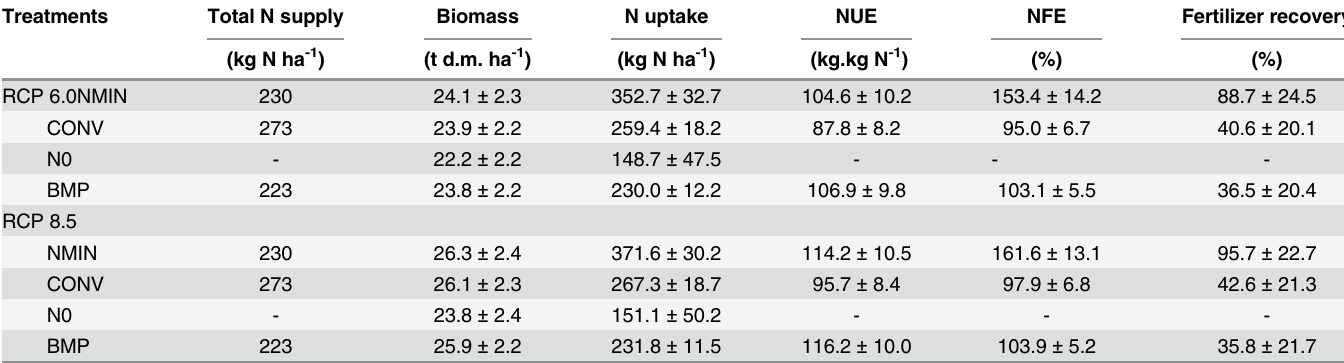
Table 10. Simulated yearly averages of total N supply, biomass (expressed as dry matter), N uptake, N use efficiency (NUE), N fertilizer efficiency (NFE) and fertilizer recovery related to the maize crop for the NMIN, CONV, N0 and BMP treatments in the long-term rotation (2020 – 2073). Results report means and standard errors.